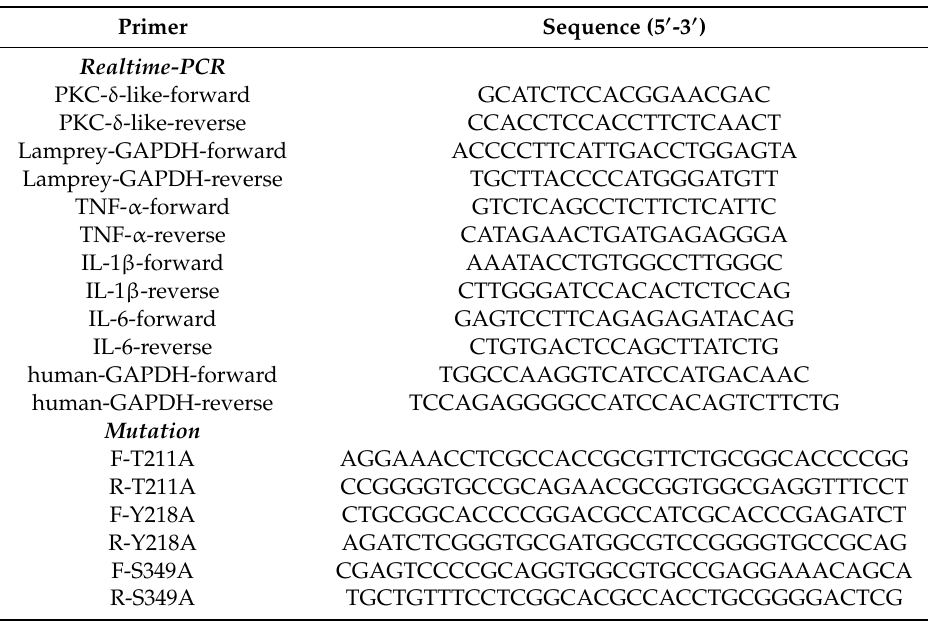
Table 1. Oligonucleotide Primers Used in the